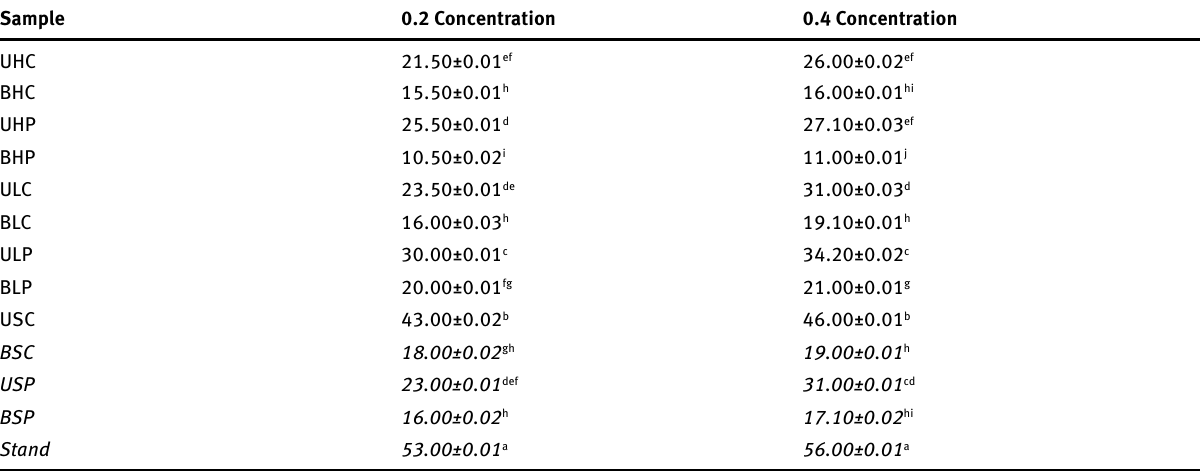
Table 1: Total Phenolic Content (µgGAE/100g) of Flour Sample